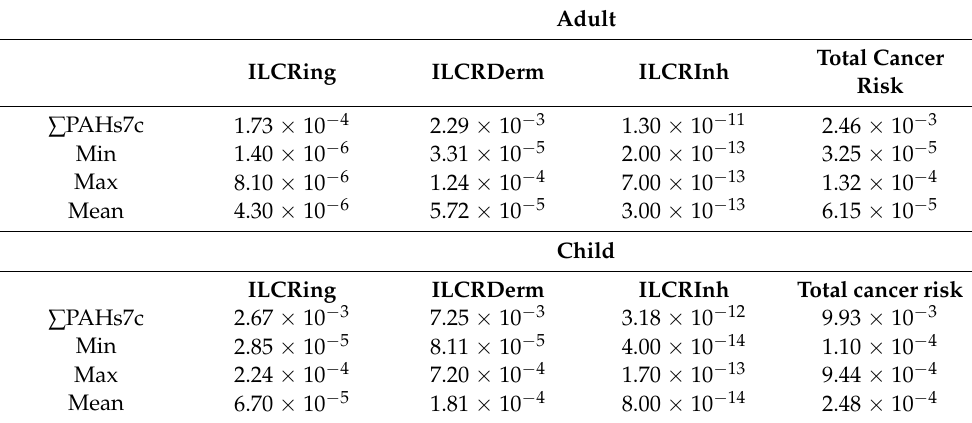
Table 7. Cancer risk of PAHS in the river bed sediments of the study